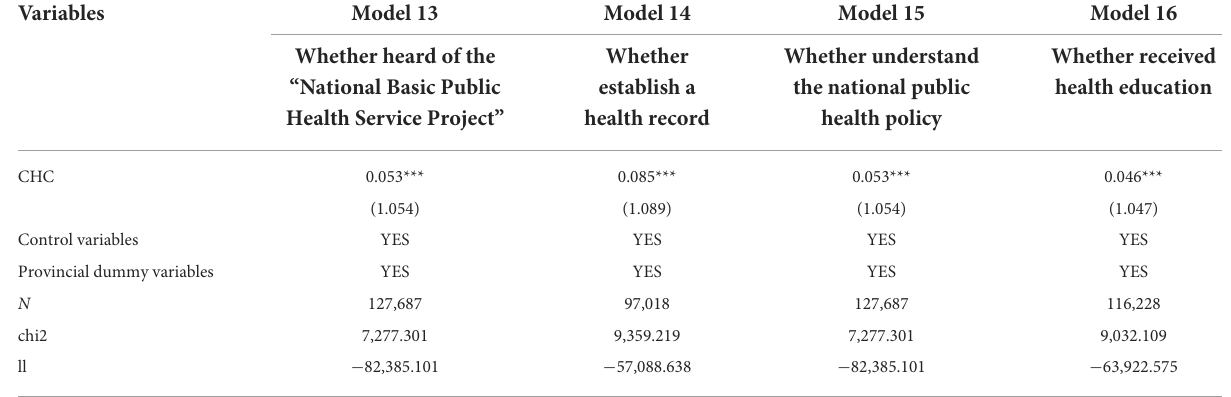
TABLE 7 Explanatory mechanisms of CHC on SRH at the destination (1).